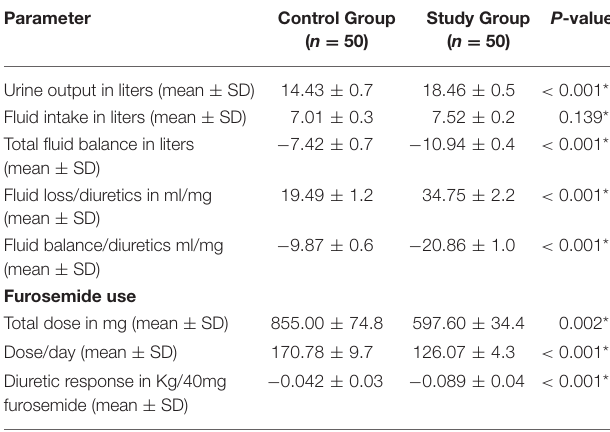
TABLE 1 | Baseline characteristics of the studied population. TABLE 2 | Change associated with diuresis in the studied population.